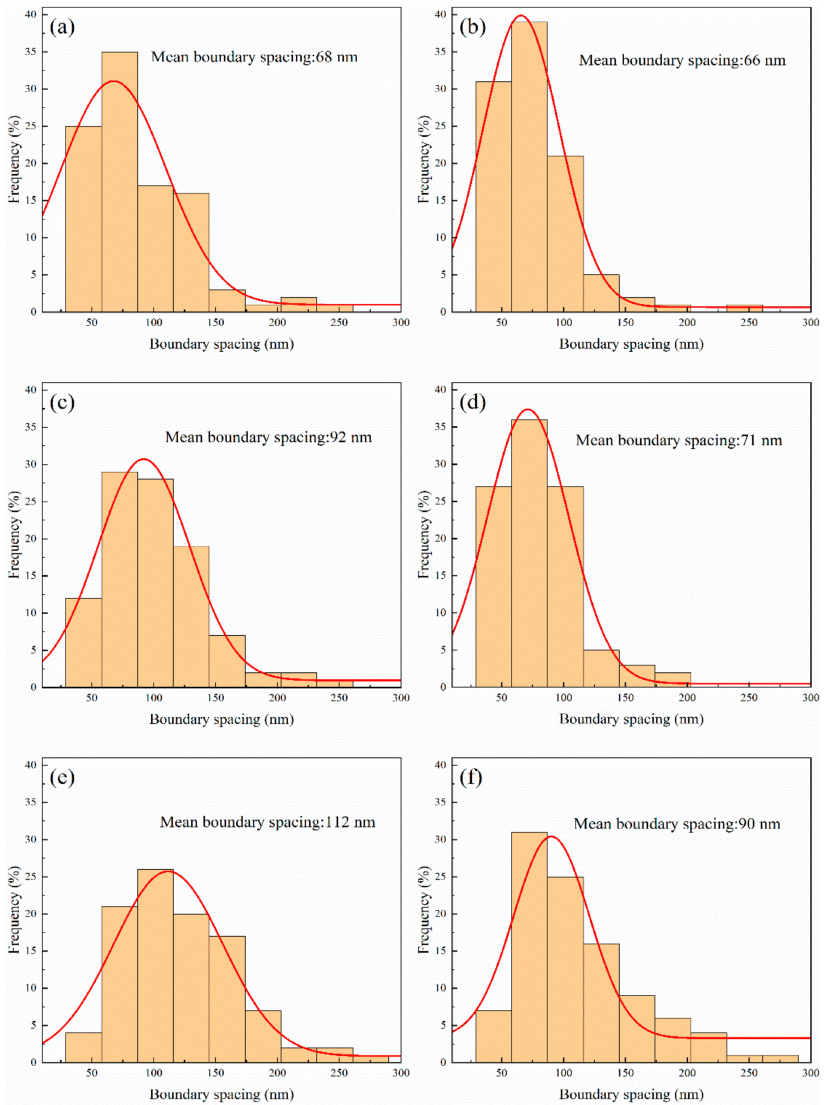
Figure 3. Histograms of boundary spacing of Ni sheets subjected to ( a ) room-temperature rolling and subsequent annealing at ( c ) 75 ◦ C and ( e ) 160 ◦ C for 1 h, and ( b ) cryorolling and subsequent annealing at ( d ) 75 ◦ C and ( f ) 160 ◦ C for 1